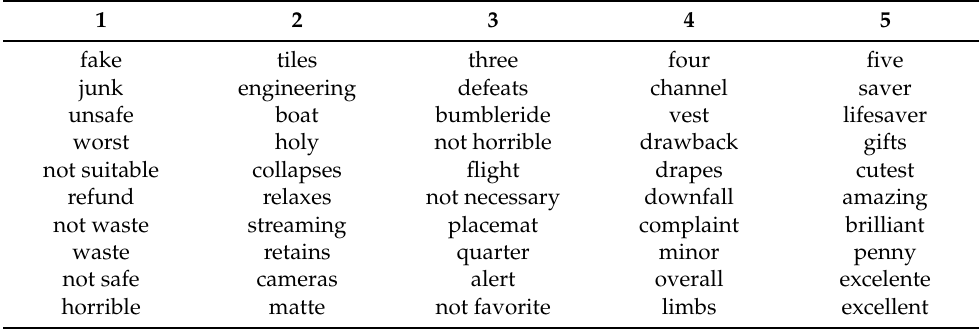
Table 4. Top 10 feature terms related to each star (baby pacifier).